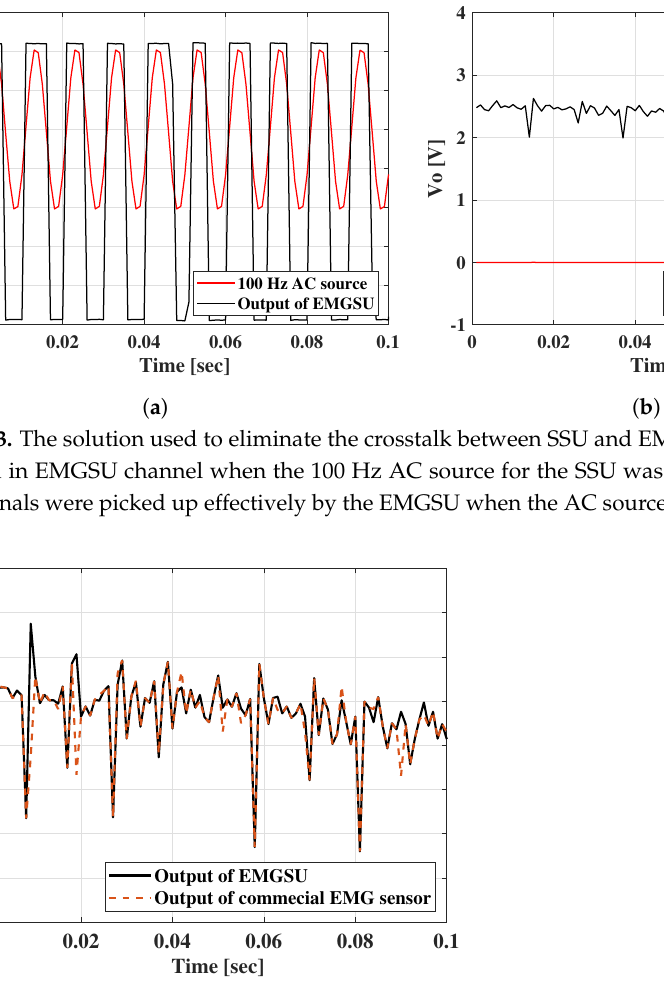
Figure 14. Comparison of EMG measurements between a commercial EMG sensor and our